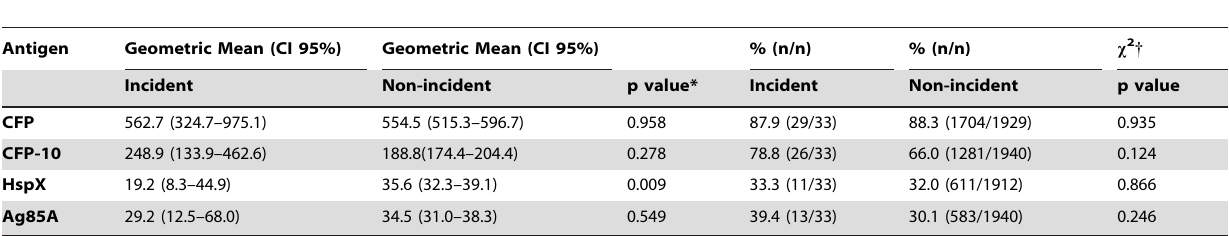
Table 5. Comparison of baseline IFN c production by TB incident and non–incident HHCs in response to the antigens used.